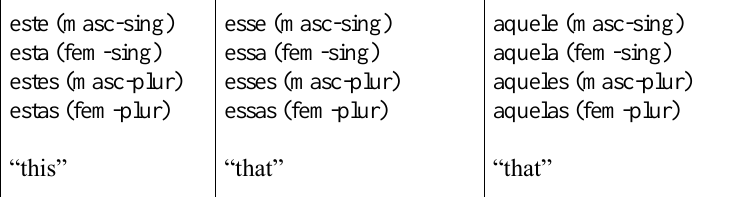
Table I – Demonstrative pronouns in